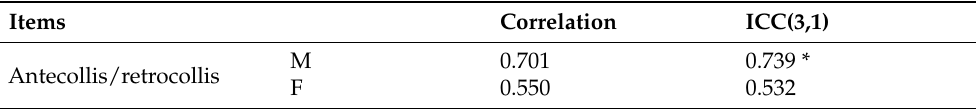
Table 5. Validity and accuracy of the multi-view vision based method and the single-view vision based method.